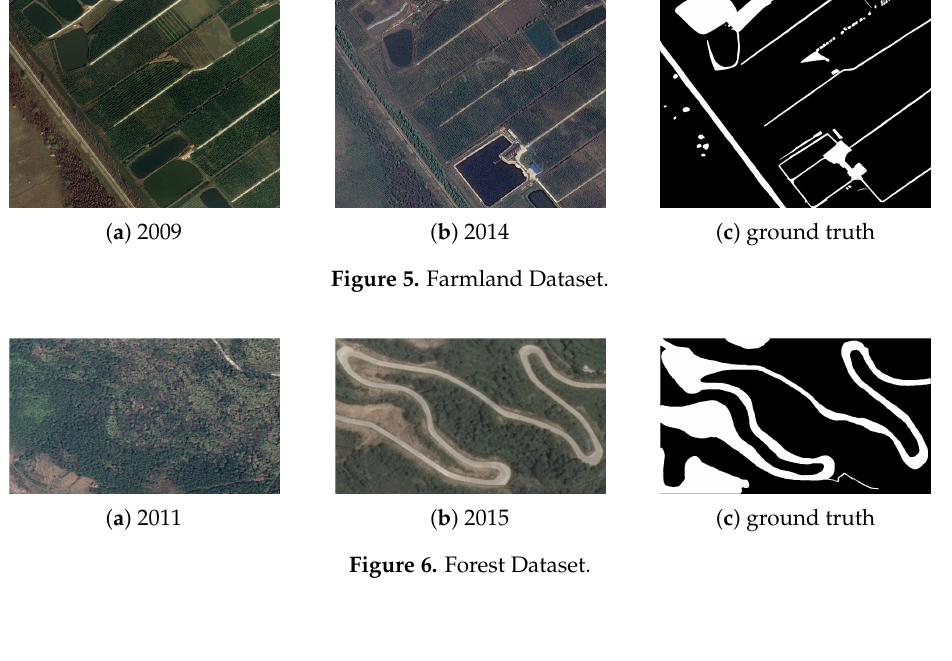
Figure 6. Forest